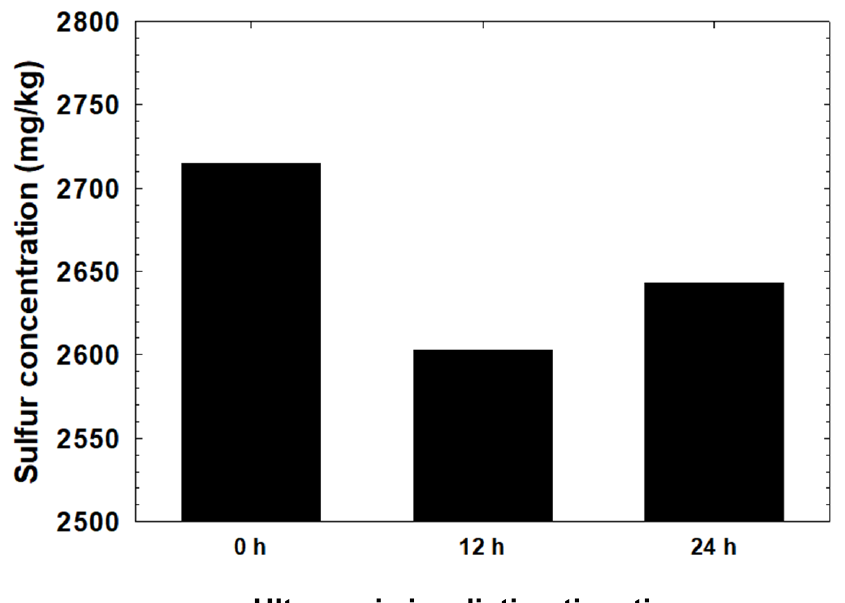
Figure 6. Variation in the sulfur concentration for 100% B-A with ultrasonic irradiation time.